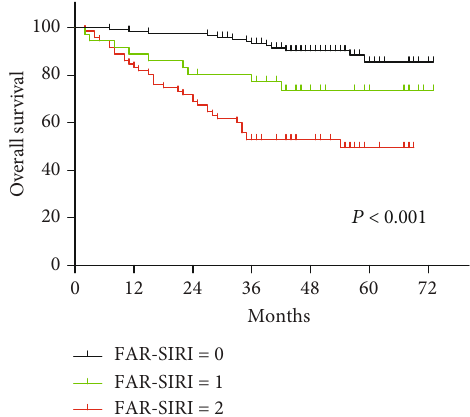
Figure 3: E ff ects of recombination of FAR and SIRI (FAR-SIRI score) on the survival of GC patients. FAR-SIRI score 0 represents patients with SIRI < 0 : 84 ; FAR-SIRI score 1 represents patients with FAR score < 0 : 071 and SIRI score ≥ 0 : 84 . Patients with FAR score ≥ 0 : 071 and SIRI score ≥ 0 : 84 were assigned a FAR-SIRI score of 2. P value was calculated by the log-rank